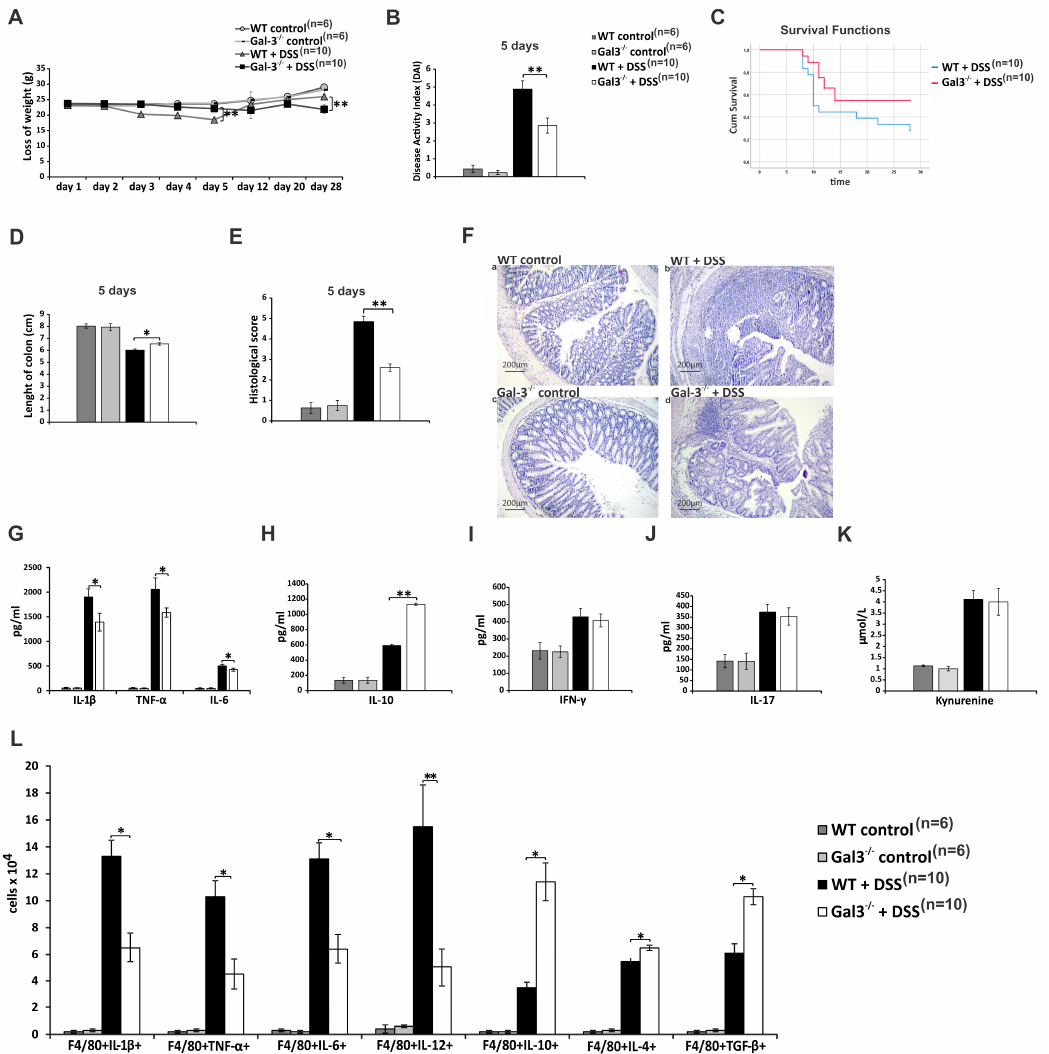
Figure 1. Gal-3 has pro-inflammatory role in induction phase of DSS-induced colitis. 2.2% DSS was given to mice for 5 days while regular drinking water was given to control animals. DSS-induced loss of weight ( A ); Disease Activity Index DAI ( B ); and survival rate ( C ) 5 days after colitis induction. Length of colon ( D ) and histological score ( E ) of DSS-treated mice. Haematoxylin and eosin (H&E) stained colon tissue samples of DSS-treated mice (magnification 100 × ) ( F ). Concentrations of IL-1 β , TNF- α , IL-6 ( G ), IL-10 ( H ), IFN- γ ( I ), IL-17 ( J ), and KYN ( K ) in serum samples of DSS-treated mice at day 5. The total number M1 and M2 macrophages in colons of DSS-treated animals ( L ). Data are presented as mean ± standard error of the mean (SEM); n = 10 mice per experimental and 6 mice per control groups. * p < 0.05, ** p < 0.001.